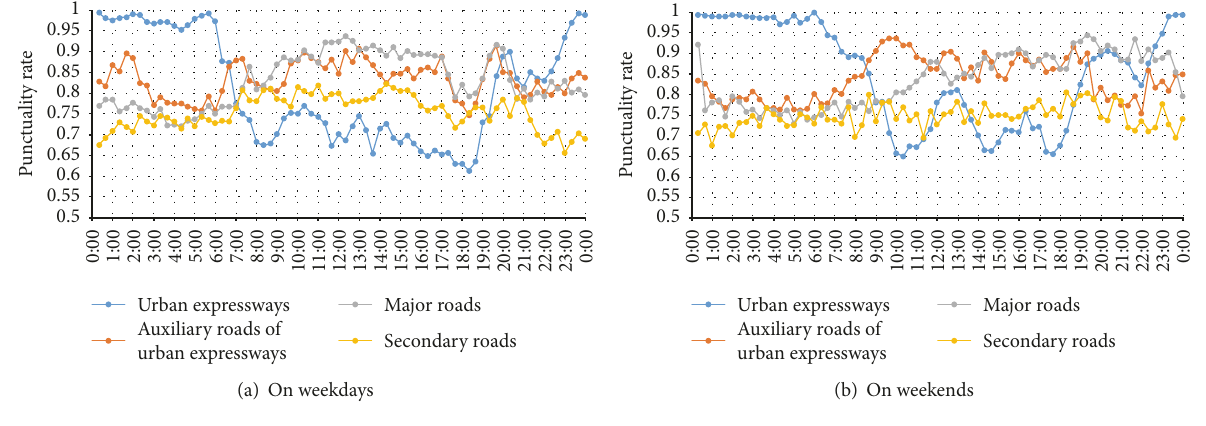
Figure 5: Punctuality rates through the